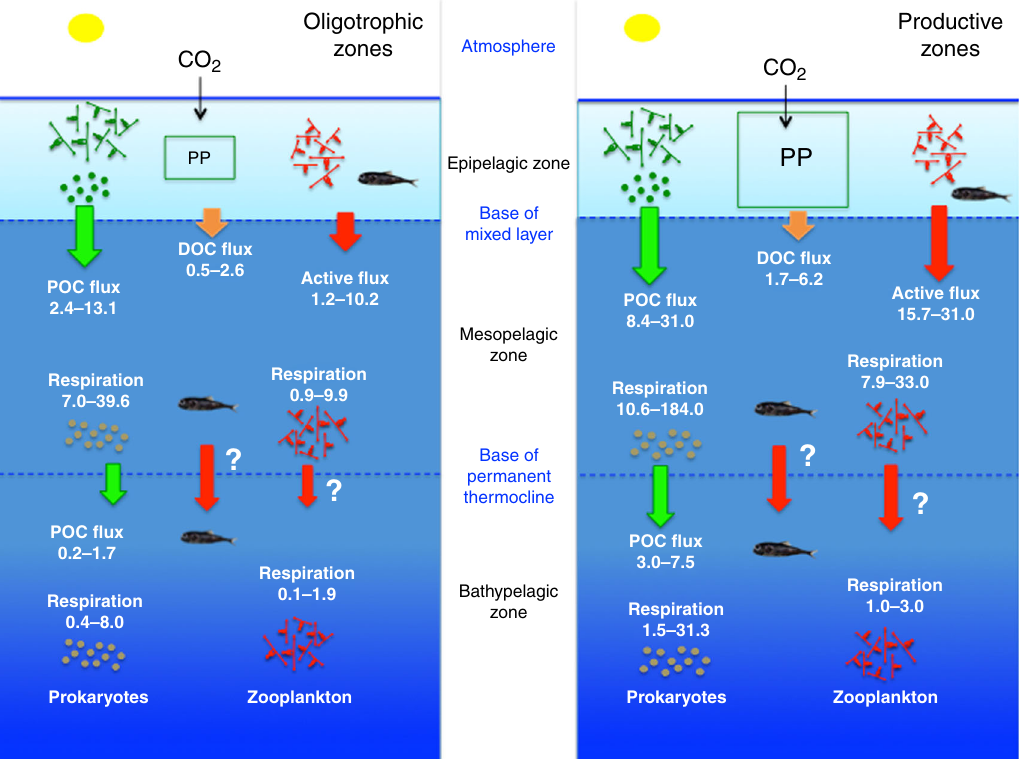
Fig. 4 Carbon export and sequestration. Synthesis of carbon export values (from the epipelagic towards the mesopelagic zone) and sequestration (from the mesopelagic towards the bathypelagic zone) of particulate organic carbon (POC, green arrows) fl ux, active fl ux due to migrant zooplankton, and micronekton (red arrows), and estimated dissolved organic carbon (DOC, orange arrows) fl ux (as 20% of POC fl ux, see text). Values are given in gCm − 2 y − 1 , to compare values in oligotrophic (left panel) and productive systems (right panel). POC and active fl uxes are higher in productive zones, as expected, but active export fl ux is proportionally higher in productive zones as recently observed in the tropical and subtropical Atlantic Ocean 9 . Values of prokaryote and zooplankton respiration are also higher than POC, DOC, and active fl uxes for both export and sequestration. Active sequestration fl ux is, at present, unknown (re fl ected by a question mark in both panels) and it should also explain, at least in part, the higher respiration rates in the bathypelagic zones. Finally, active sequestration fl ux and respiration by macrozooplankton and micronekton should tend to balance the budget (see text), and they are also represented as question marks in the Figure.